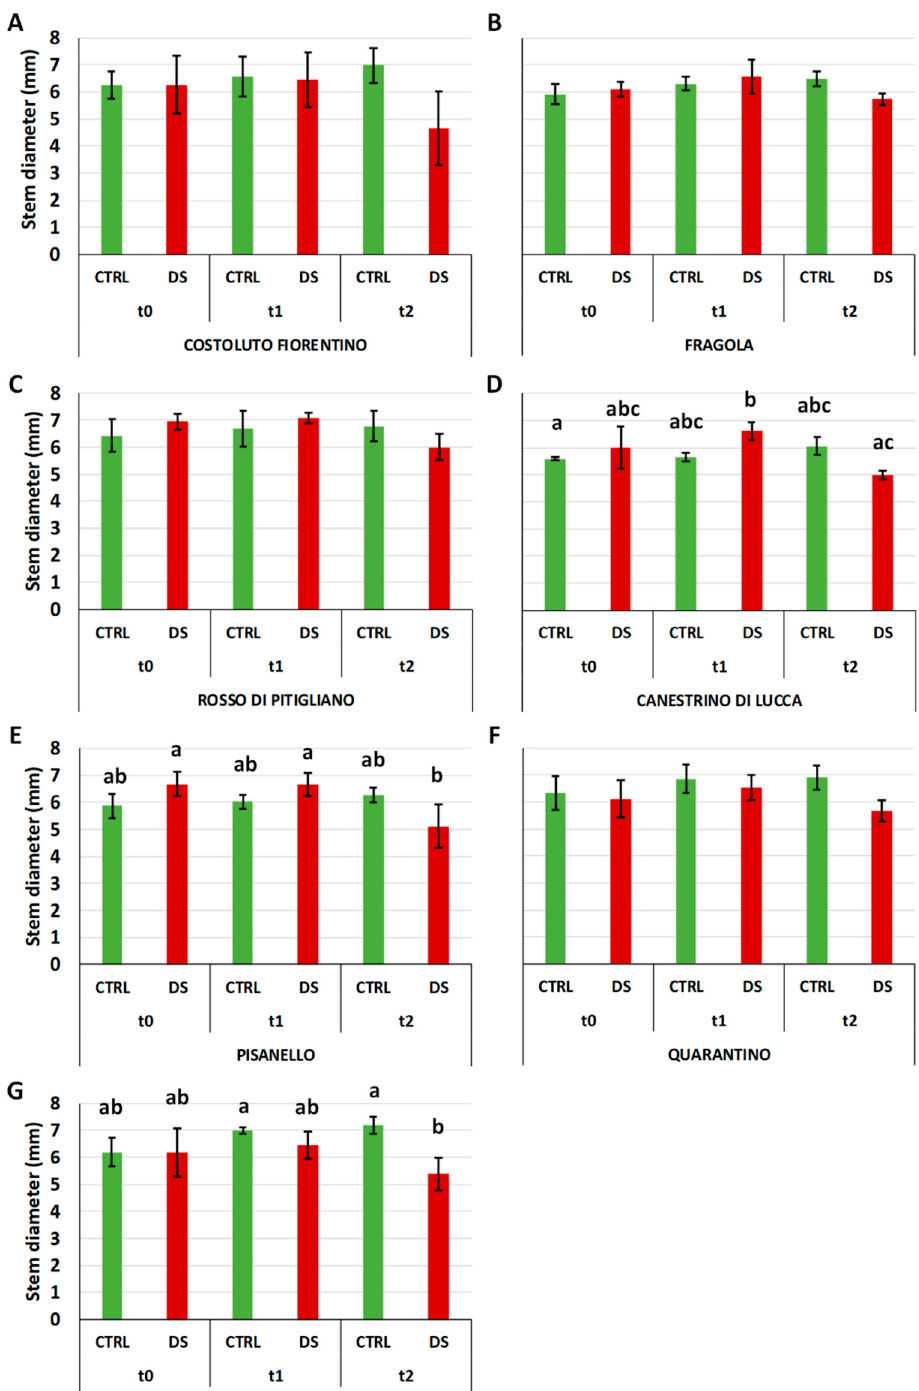
Figure 5 . Stem diameter in six local varieties ( A – F ) and one commercial cultivar ‘Supersteak’ ( G ) of tomato ( Solanum lycopersicum L.) subjected to drought stress (no water for 16 days) relative to the controls (regularly well-watered plants). Two-way factorial ANOVA followed by Tukey post-hoc test was used to determine the statistical significance of differences. Points with the same lower-case letters do not differ significantly ( p > 0.05).